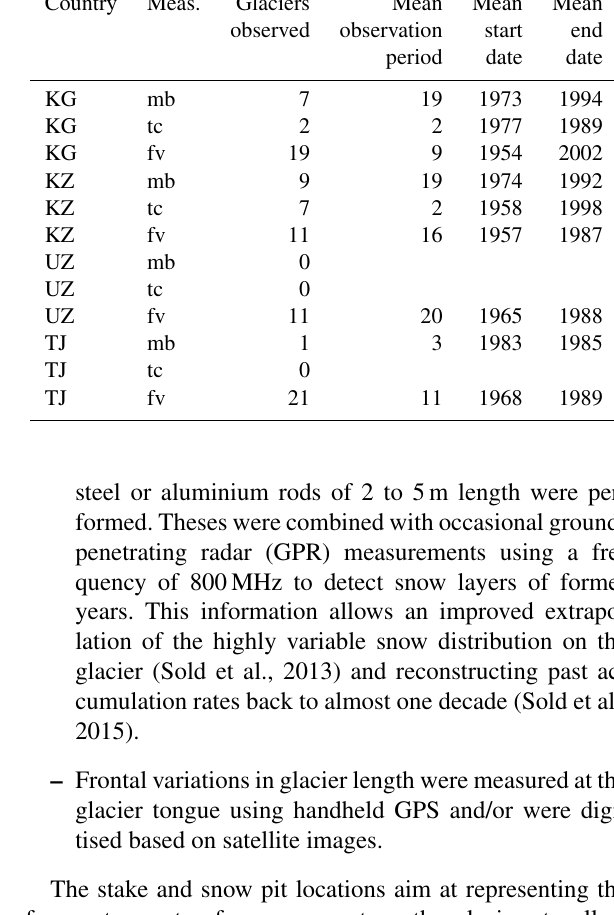
Table 2. Information on glaciers before the re-establishment of the measurements was initiated based on WGMS (2013). Abbre- viations: KG, Kyrgyzstan; KZ, Kazakstan; UZ, Uzbekistan; TJ, Tajikistan; mb, mass balance measurements; tc, geodetic thickness change; fv, front variations.